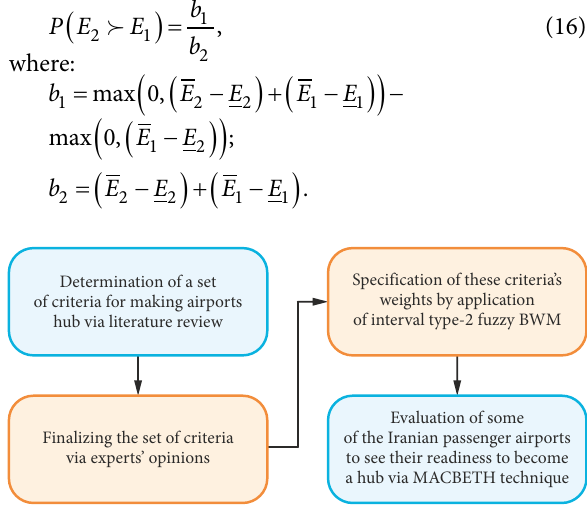
Determination of a set of criteria for making airports hub via literature review